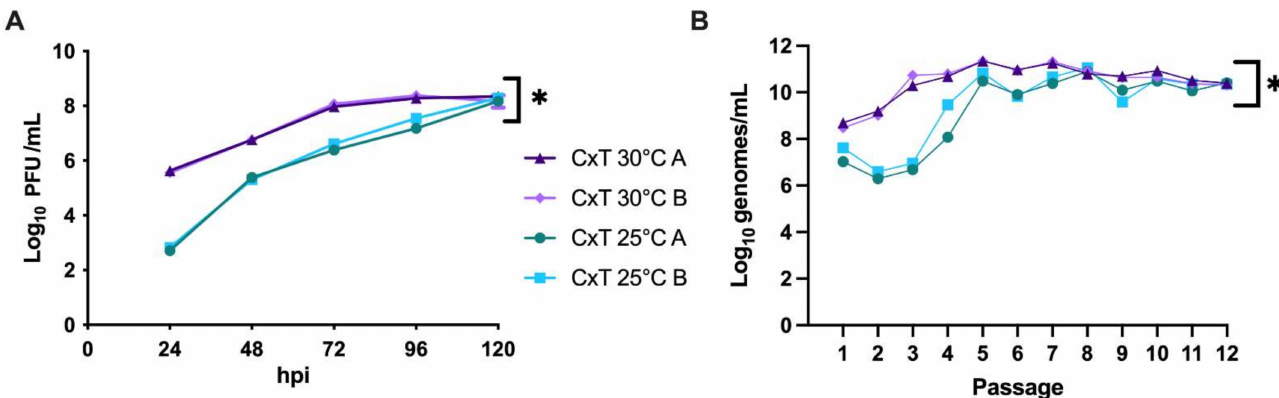
Figure 2. Temperature-dependent replication of West Nile virus in Culex cell culture. ( A ) Growth kinetics of WNV02 IC passage 1 in Culex tarsalis (C × T) cells at 25 ◦ C and 30 ◦ C. Viral loads were determined via plaque titration and kinetics are shown as means of duplicate assay. Significantly higher output titers were measured at 30 ◦ C relative to 25 ◦ C (* p < 0.05 (one-way ANOVA w/multiple comparisons, Tukey’s post-test)). ( B ) Output viral load during passage of WNV02 IC. Viral RNA levels were quantified at 96 h post-infection by real-time RT-PCR using genome copy standards. Significantly higher output titers were measured at 30 ◦ C relative to 25 ◦ C (* p < 0.05 (one-way ANOVA w/multiple comparisons, Tukey’s